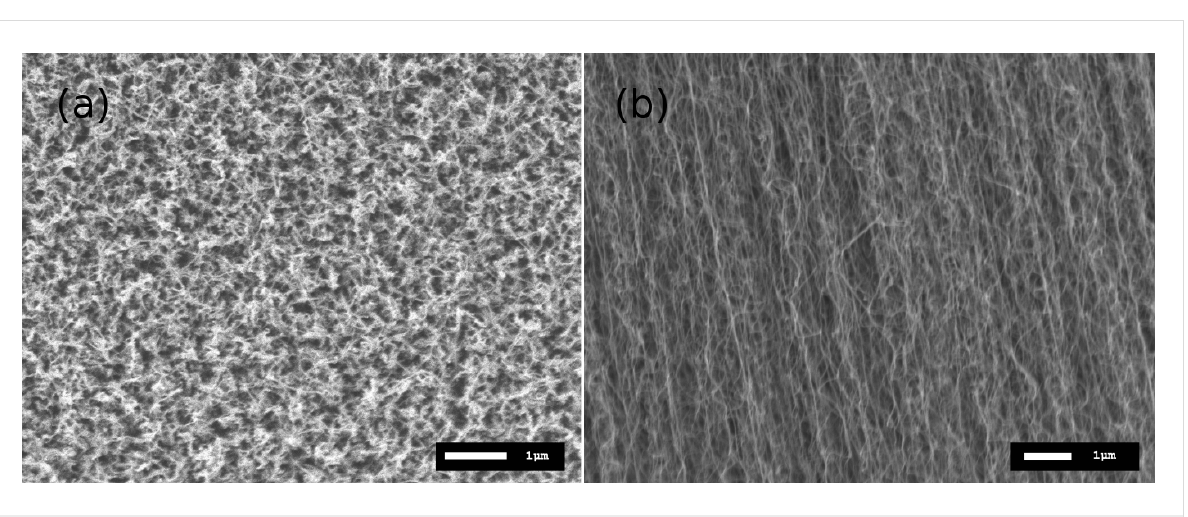
Figure 2: (a) Top and (b) side SEM views of the VA-CNTs.